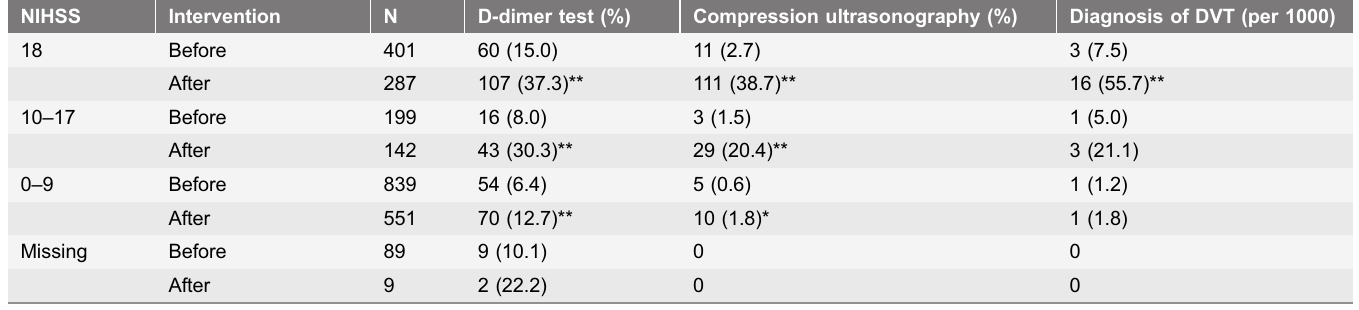
Table 3. Comparisons for D-dimer test, compression ultrasonography, or ultrasound diagnosis of deep vein thrombosis between patients who were admitted before and after intervention according to stroke